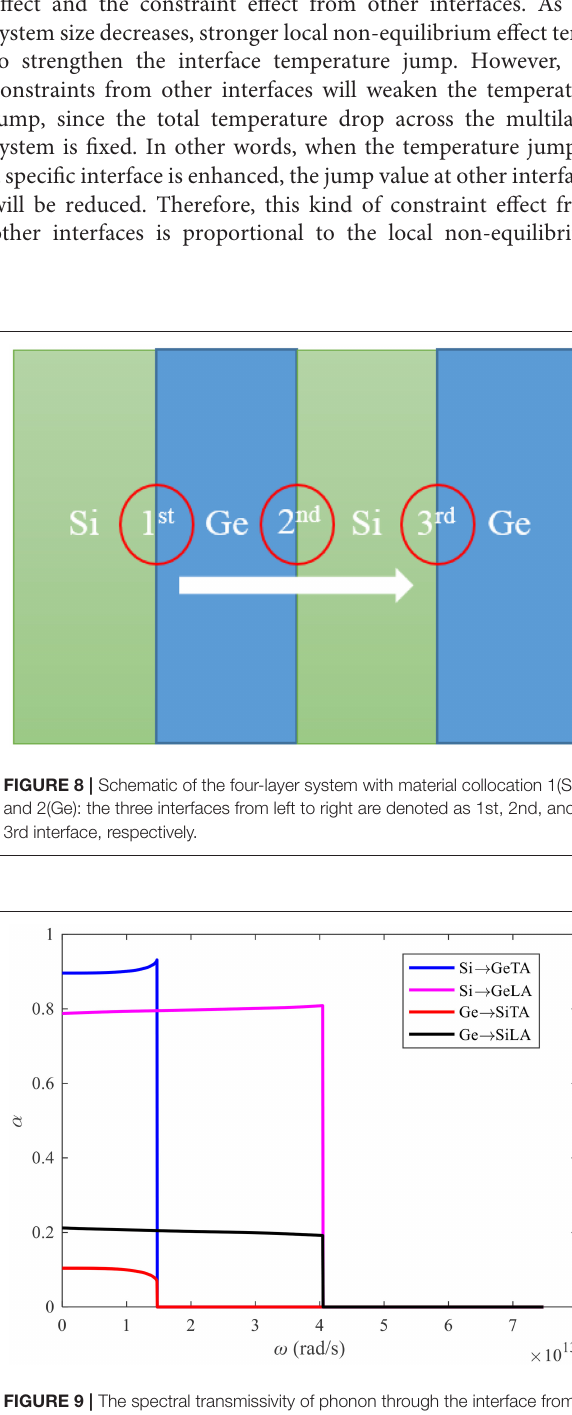
FIGURE 9 | The spectral transmissivity of phonon through the interface from Si to Ge or from Ge to Si for transverse acoustic (TA) polarization and longitudinal (LA) polarization, respectively.